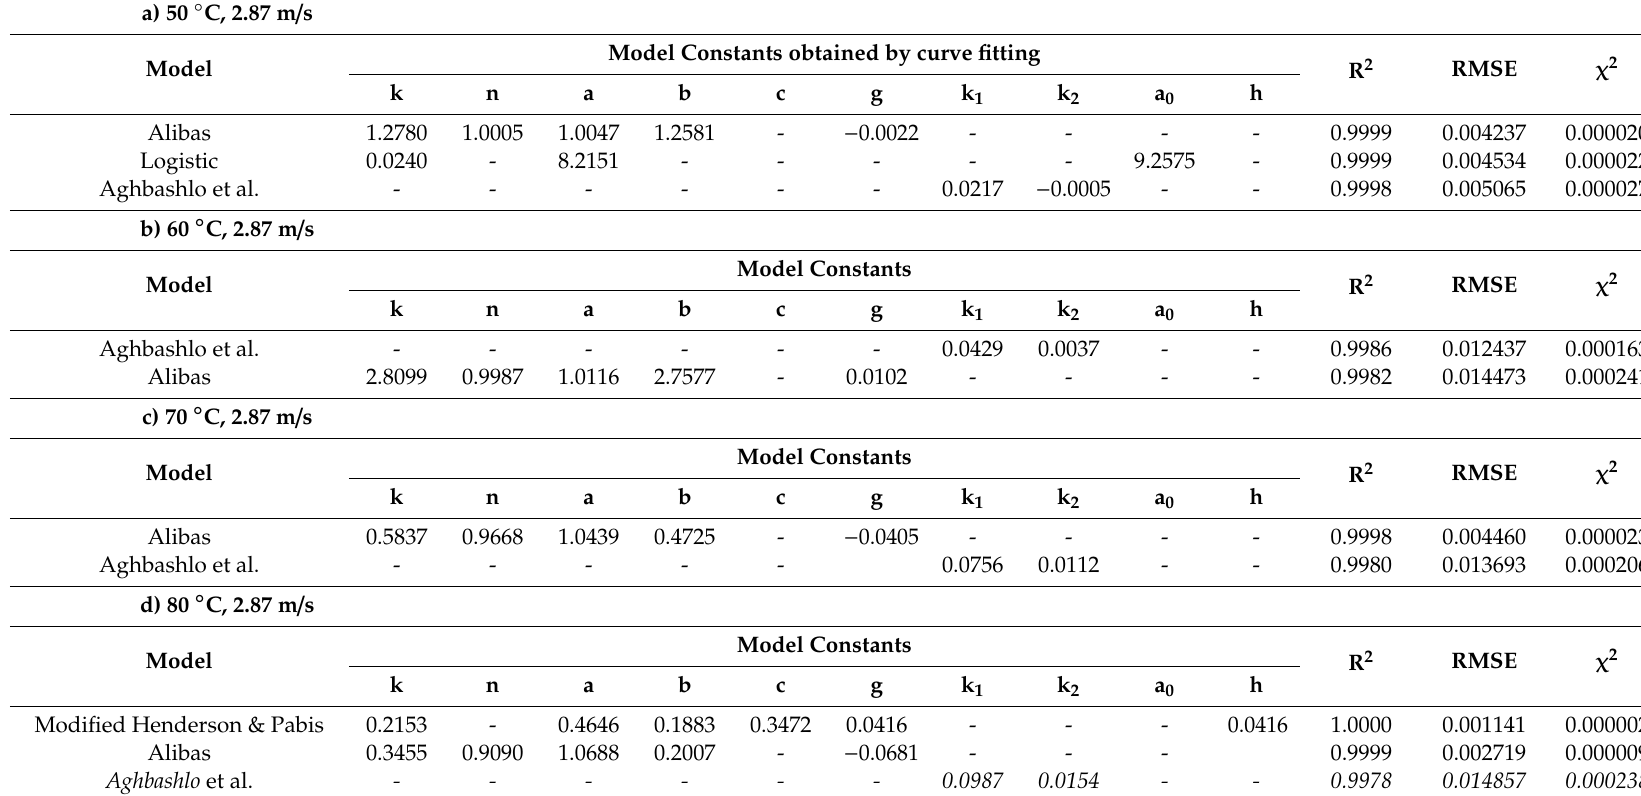
Table 4. Thin layer model fit and constants for pumpkin seeds dried at a) 50 ◦ C, b) 60 ◦ C c) 70 ◦ C and d) 80 ◦ C at a constant air velocity of 2.87 m /